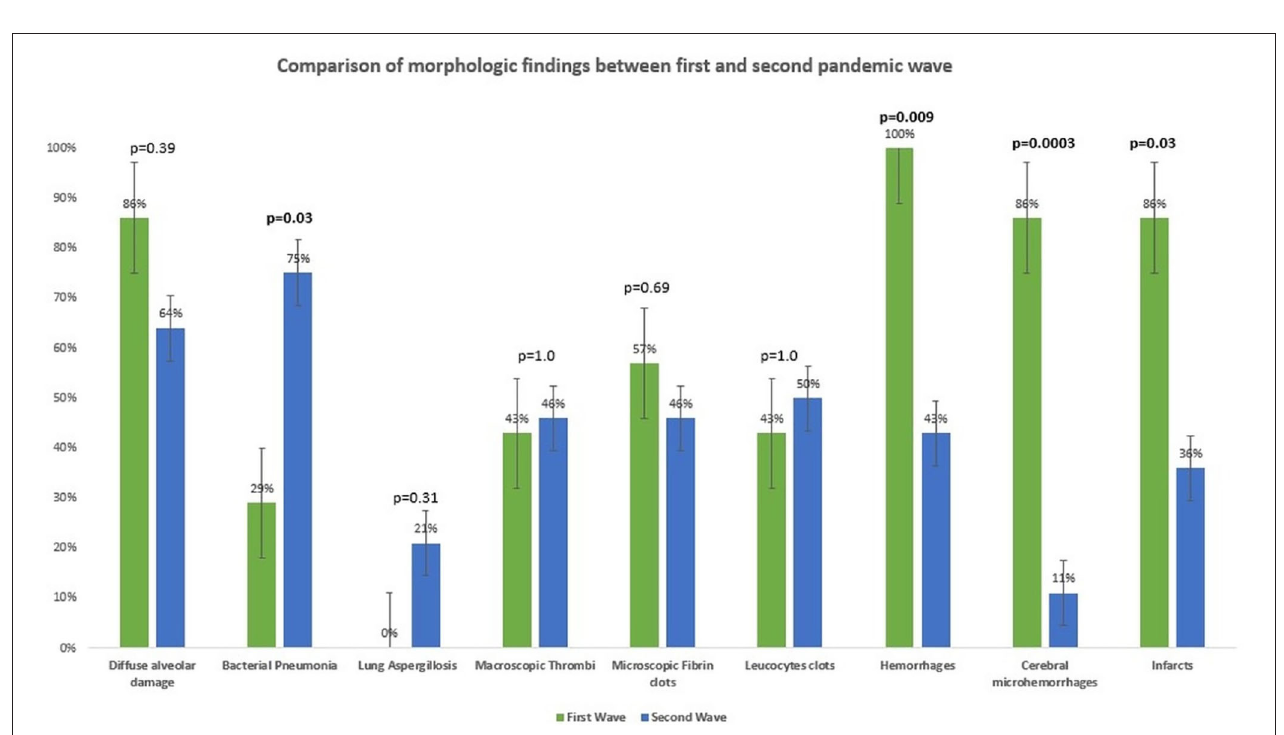
FIGURE 10 | Comparison of morphologic findings at autopsy between first and second pandemic waves.